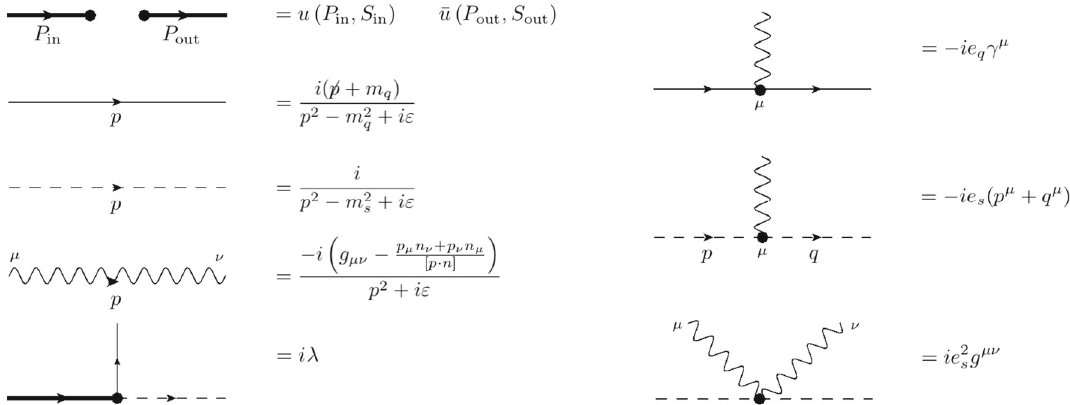
Fig. 4 Feynman rules for the scalar diquark model with a point- like quark-nucleon-diquark coupling derived from the lagrangian in Eq. (A.1). The photon propagator is considered in the light-front gauge A + ≡ A · n = 0 with n = ( 1 , 0 , 0 , − 1 )/